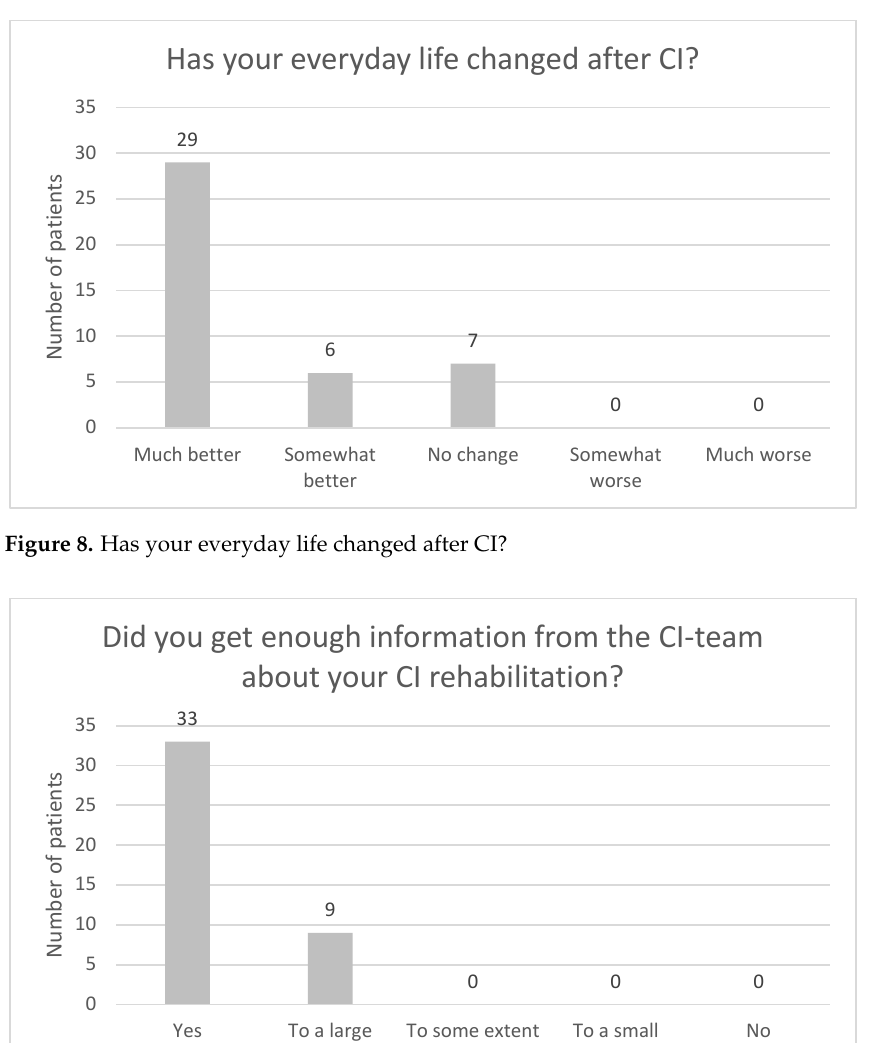
Figure 7. How often do you have problems handling your CI?